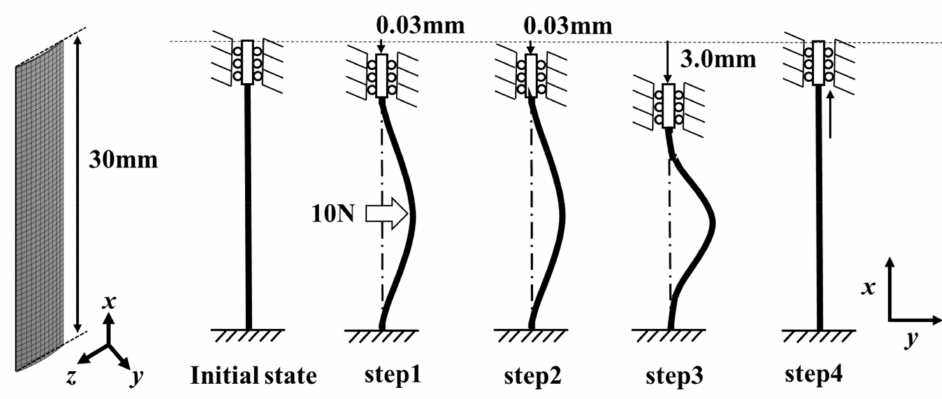
Figure 7. Three-dimensional model (3D model) of a convex tape-shaped SMA element used in the software, and the process of analysis of the buckling behavior of this tape-shaped SMA element.